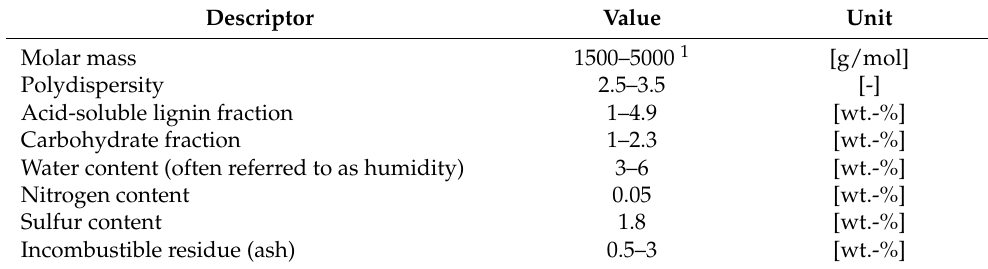
Table 3. Typical composition of kraft lignin. Data are summarized from references